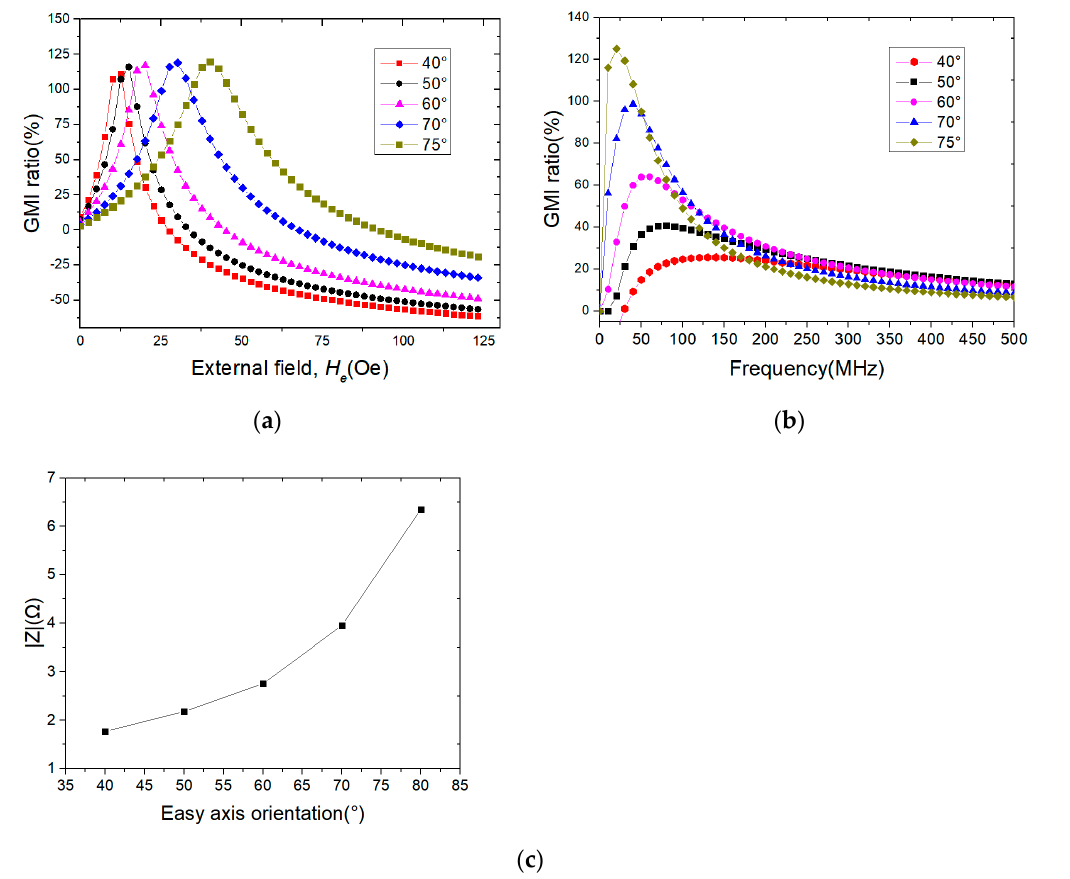
Figure 3. Effect of easy axis orientation on GMI effect in cylindrical alloy fiber. ( a ) Curve of GMI effect with external field. ( b ) Curve of GMI effect with frequency. ( c ) Curve of impedance value with easy axis orientation.